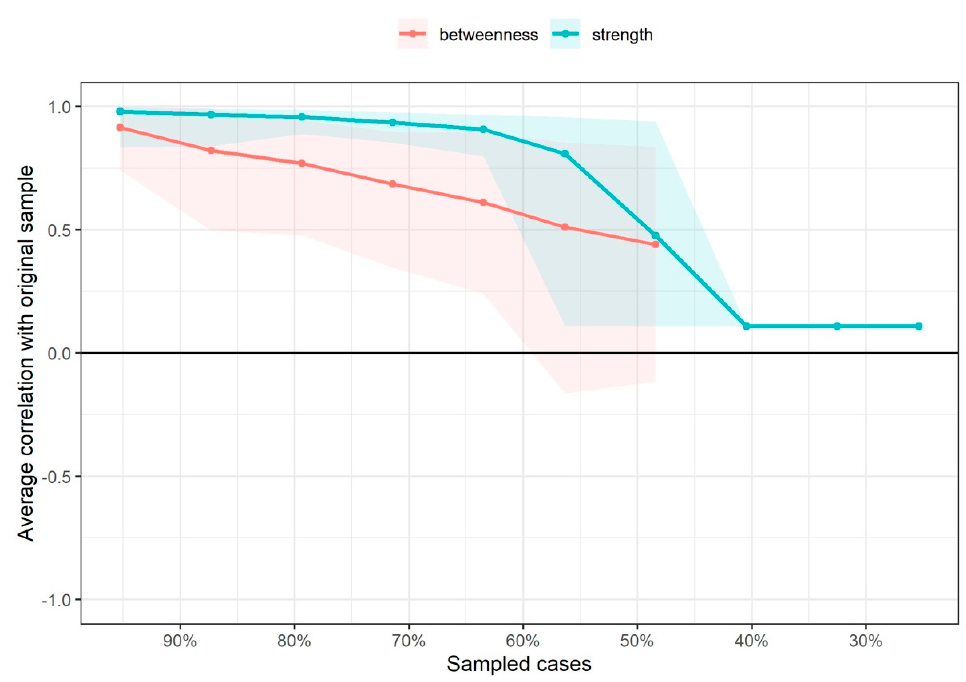
Figure 6. Average correlations between centrality indices of networks sampled with persons dropped and networks built on the entire input dataset at all follow-up time points. Lines indicate the means and areas indicate the range from the 2.5th quantile to the 97.5th quantile.